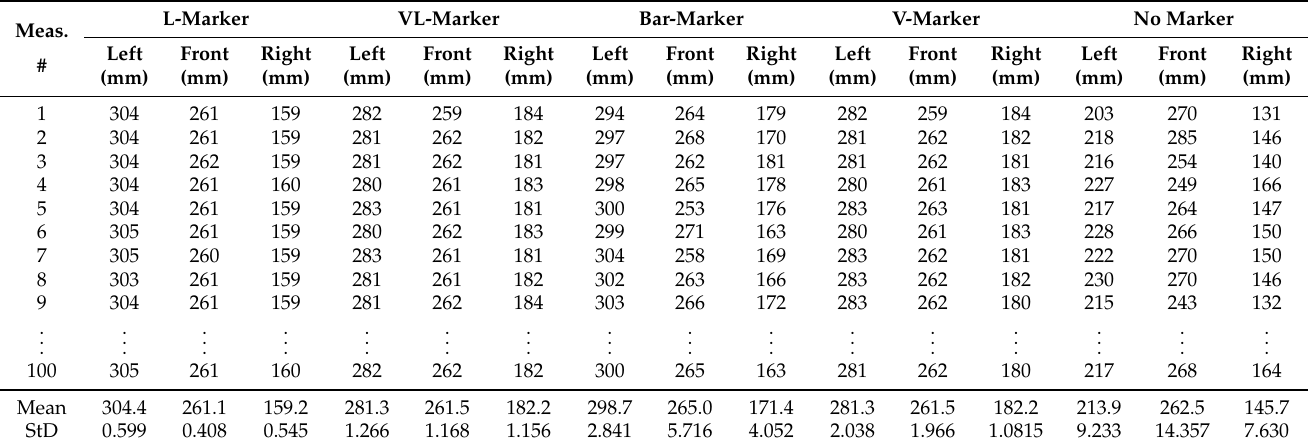
Figure 9. Box plots that compare the accuracy of individual markers on different sides. Table 4. Accuracy test